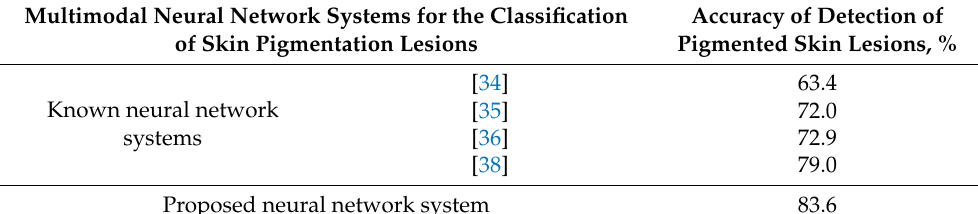
Table 6. Results of recognition accuracy of various multimodal neural network systems for recogniz- ing pigmented lesions and